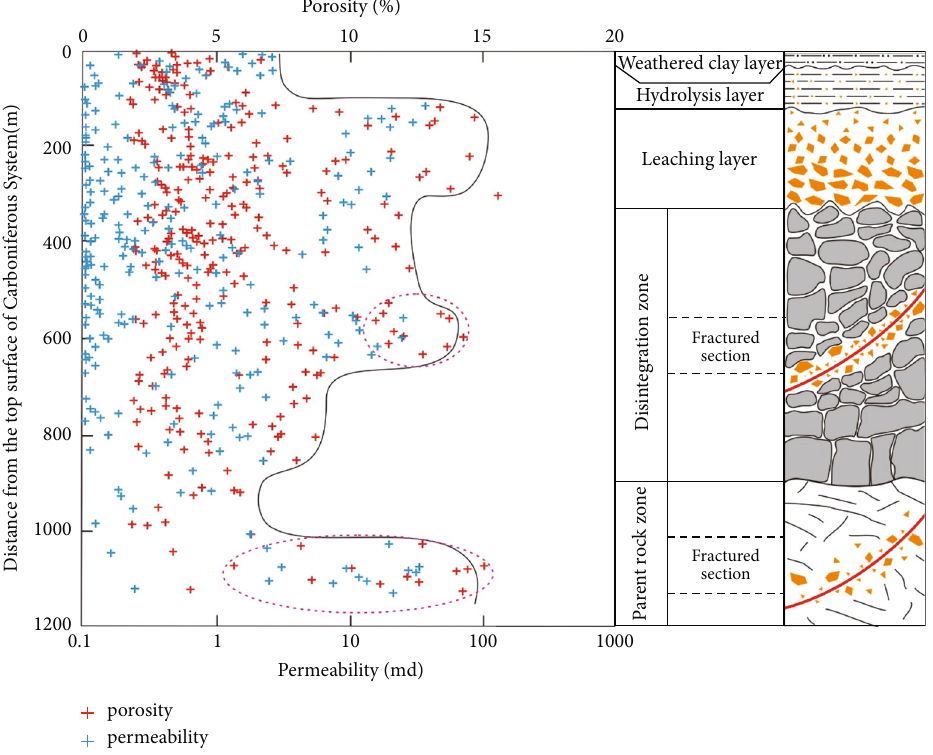
Figure 7: The structure characteristics of the Carboniferous system top weathering